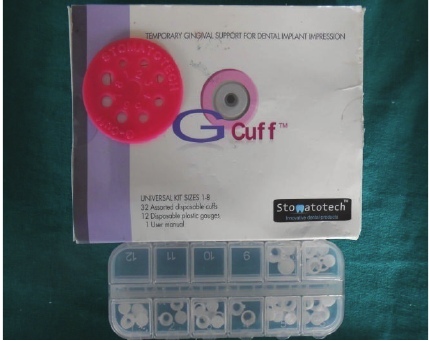
Figure 3: G-Cuff kit.